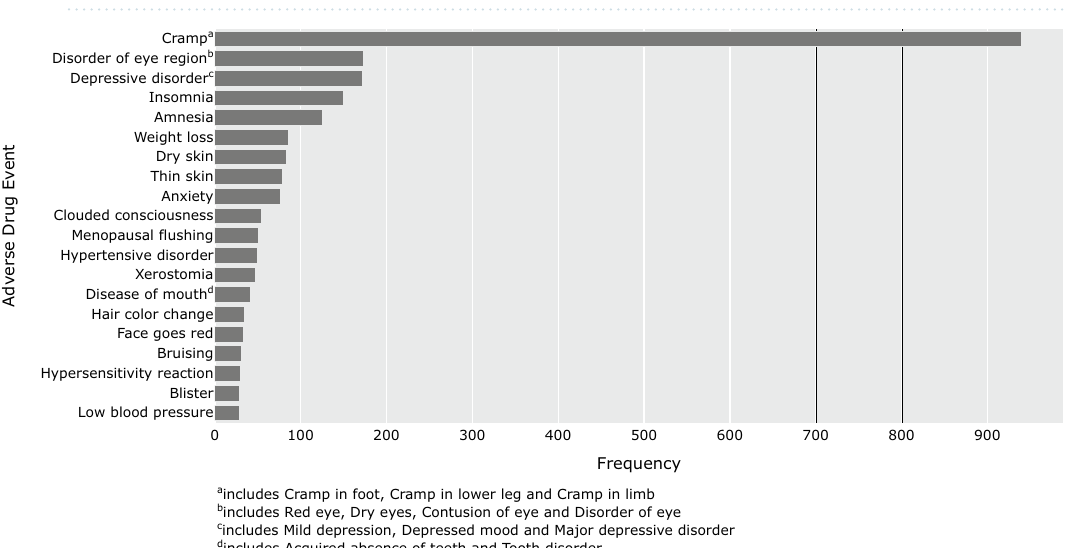
Figure 4. The 20 most prevalent long-term adverse drug events reported for imatinib on the forum.